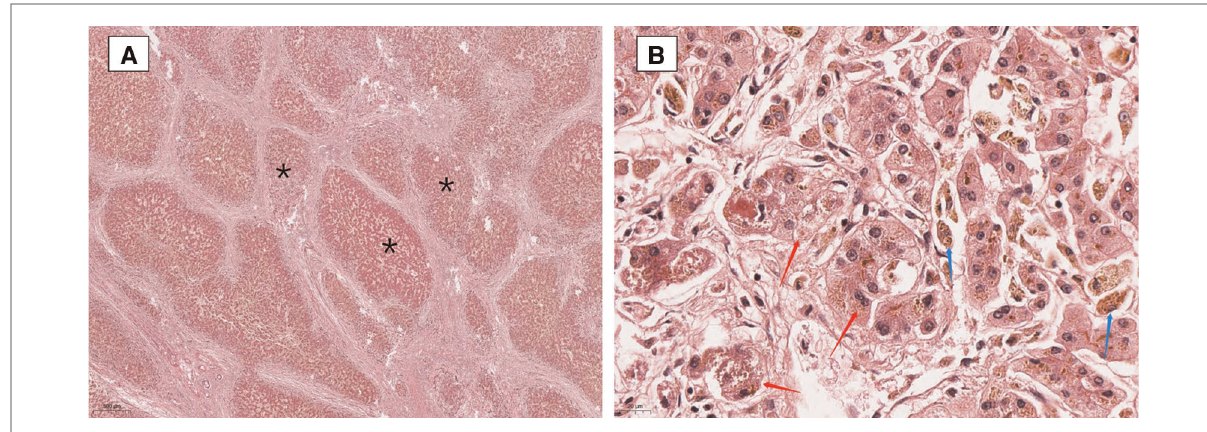
FIGURE 2 Liver biopsy showing focal nodular hyperplasia ( A is marked with “ * ” ), prominent bile ductular proliferation within fi brous bands and enlarged hepatocytes with feathery degeneration (red arrows in 2 B ), indicative of intrahepatic cholestasis. Accumulation of pigment in Kupffer cells (blue arrows in B ). (Hematoxylin and Eosin staining, ×20 and 400).